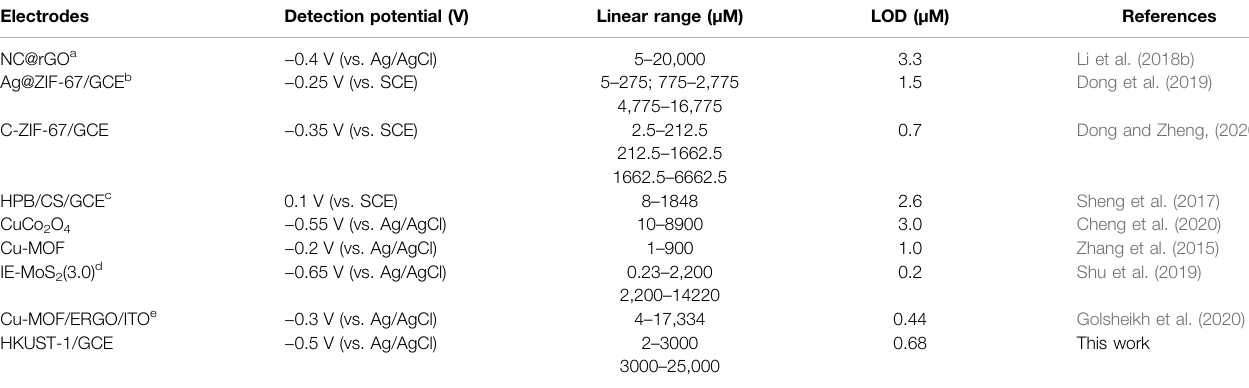
TABLE 1 | Comparison of different electrochemical platforms for hydrogen peroxide sensing.